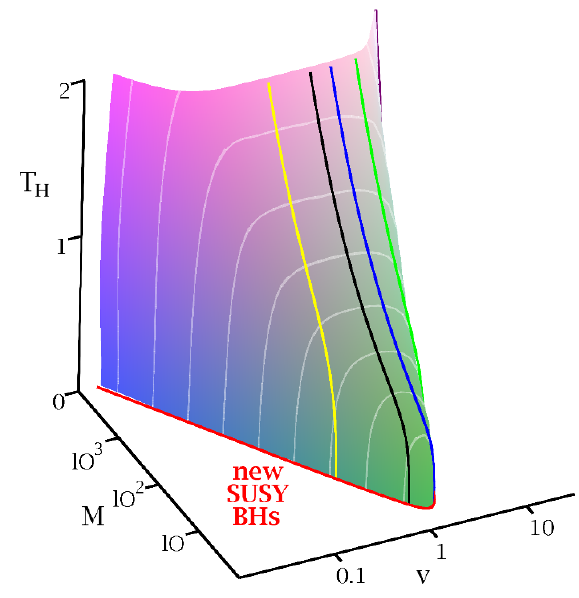
JHEP02(2018)061 Figure 5. Mass M vs. squashing parameter v vs. temperature T H for a particular set of black holes. Their magnetization parameter c m , electric charge Q and angular momentum J are given functions of v such that the extremal limit, T H = 0, corresponds to the susy black holes in section 4 (red line). Figure 6. Horizon area A H vs. horizon deformation (cid:15) vs. temperature T H for the same set of solutions in (cid:12)gure 5. In the extremal limit, T H = 0, the susy black holes in section 4 are obtained, all of them possessing the same horizon properties and being represented by a red point in this (cid:12)gure. { 19